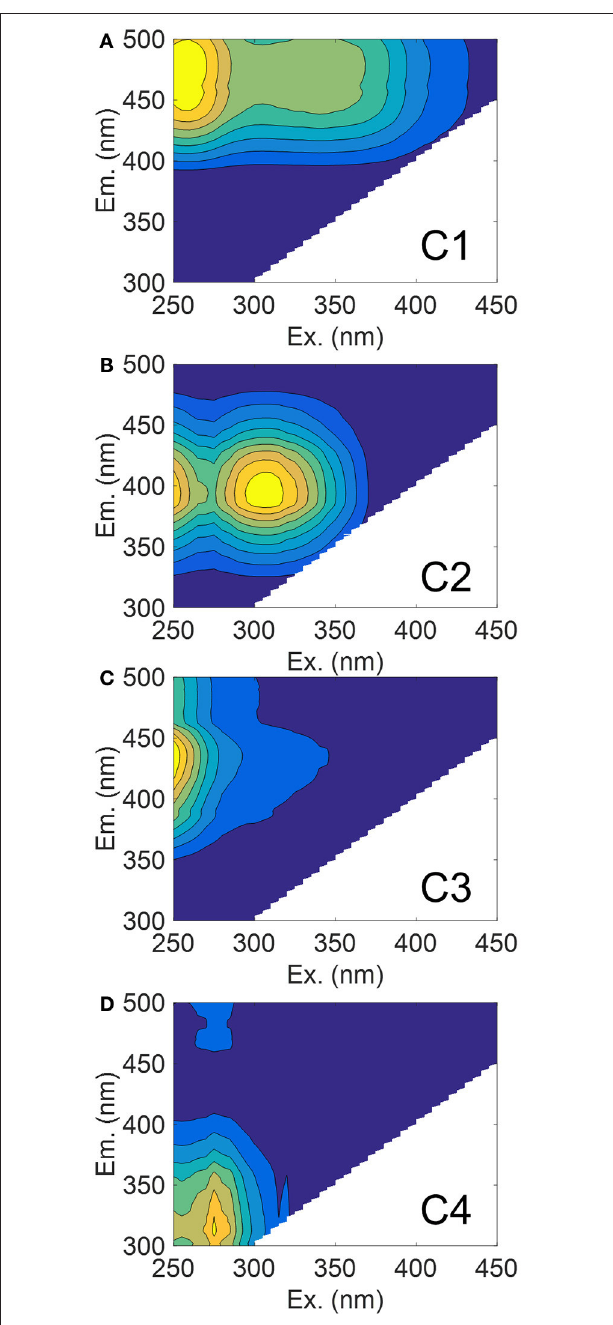
FIGURE 4 | EEM contour plots of the four PARAFAC components matched against the OpenFluor database. (A) C1 (soil fulvic acid); (B) C2 (microbial humic); (C) C3 (terrestrial humic); and (D) C4 (protein-like).